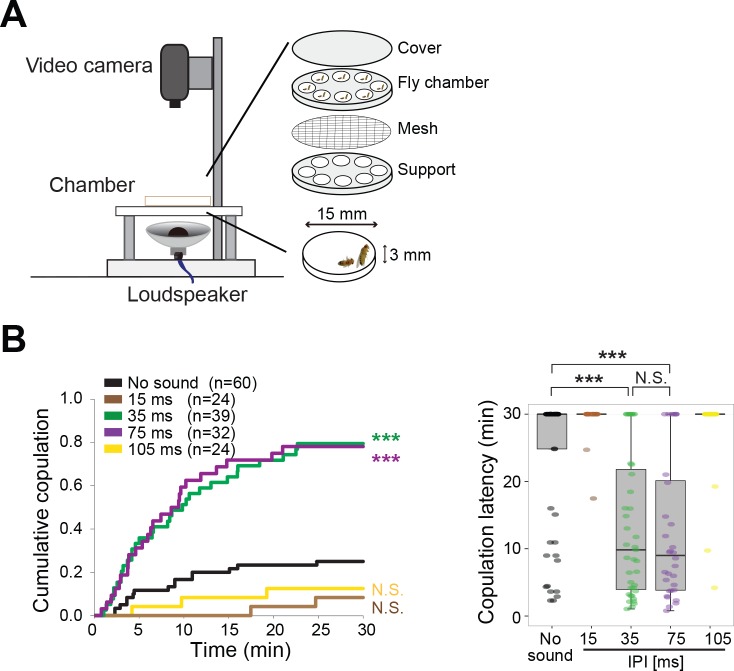
Playback of pulse song promotes copulation in wild-type fly pairs.(A) Setup for song-induced copulation test. (B) Cumulative copulation rate and copulation latency with playback of artificial pulse songs of different inter-pulse interval (IPI). Copulation latency represents the latency to accept copulation in the 30 min observation period. Boxplots display the median of each group with the 25th and 75th percentiles and whiskers denote 1.5x the inter-quartile range. N.S., not significant, p>0.05; ***p<0.001; Log rank test versus no sound group (left panel); Kruskal–Wallis test followed by Scheffe’s test (right panel). n, number of fly pairs examined.